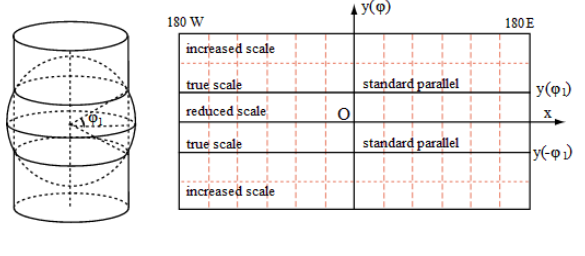
Figure 14. Secant Mercator map projection (from https://en.wikipedia.org/wiki/Mercator_projection)